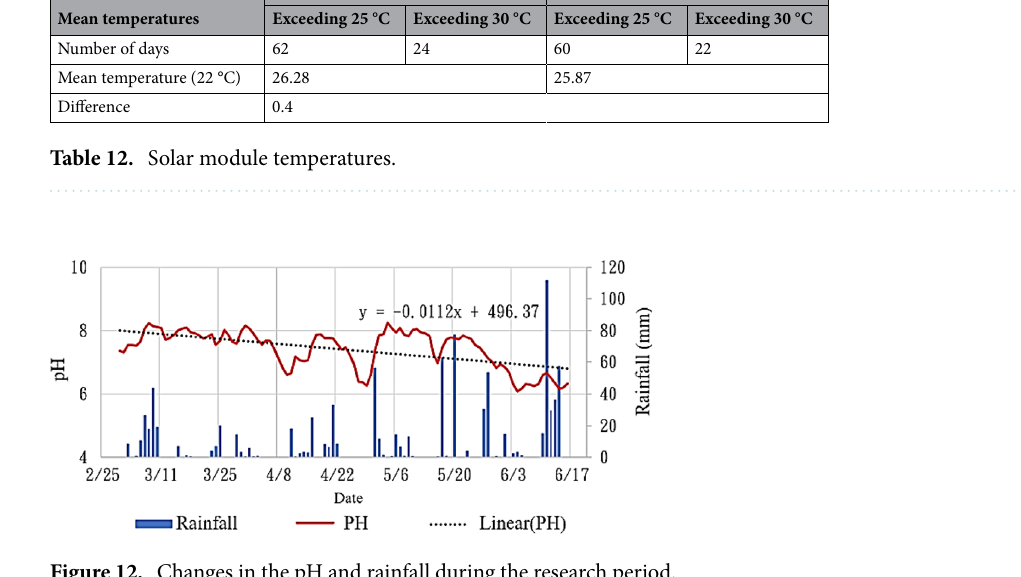
Figure 12. Changes in the pH and rainfall during the research